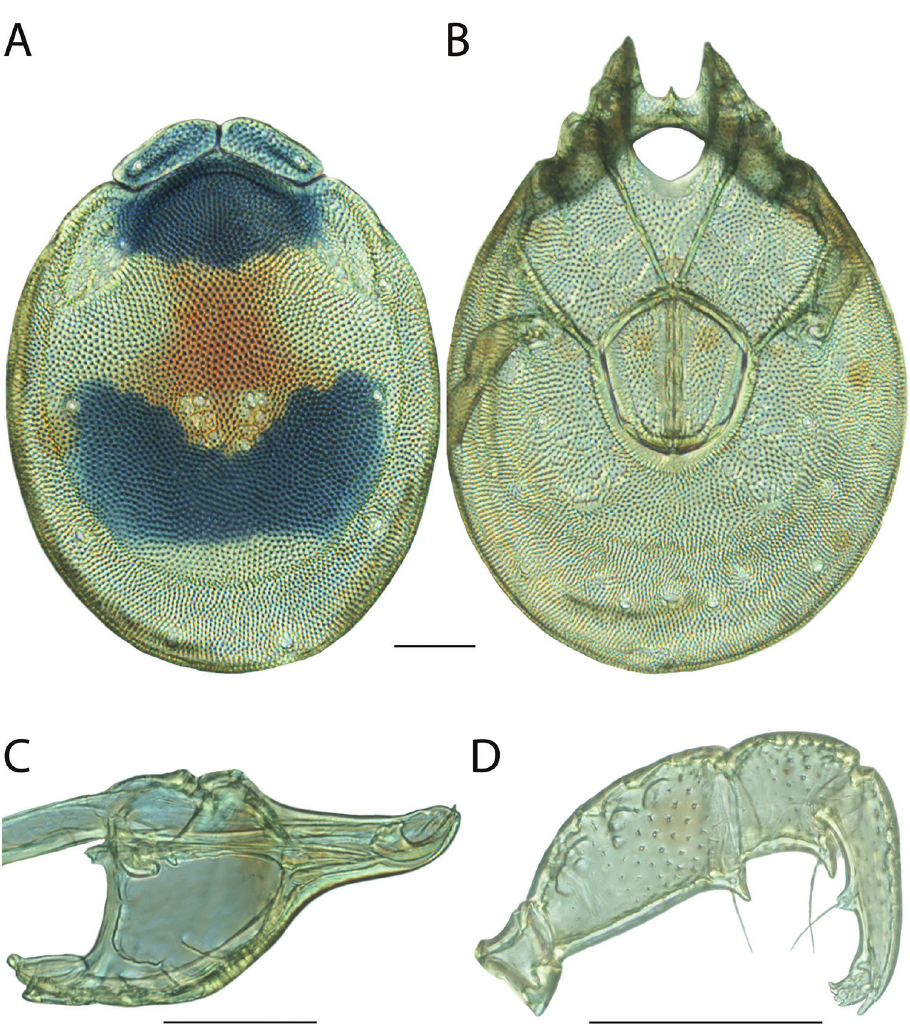
Figure 232. Torrenticola sellersorum sp. n. female: A dorsal plates B venter (legs removed) C subcapitulum D pedipalp (setae not accurately depicted). Scale = 100